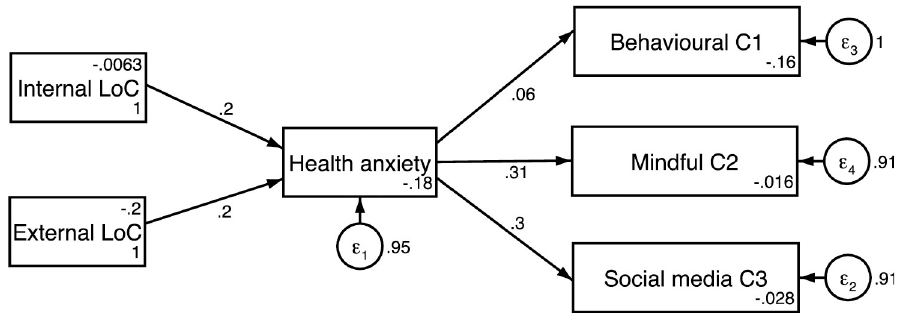
Fig 3. Structural path model for 32–45